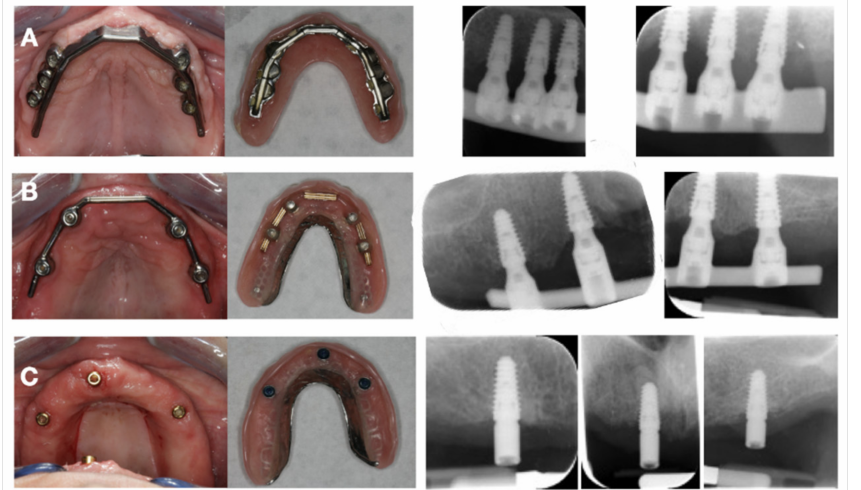
Figure 1. Restorative procedure for group IOD-6 ( A ), IOD-4 ( B ) and IOD-3 ( C ), showing the intra- oral implant position and suprastructures 3 months after placement, final prosthesis and periapical radiographs obtained after the placement of final